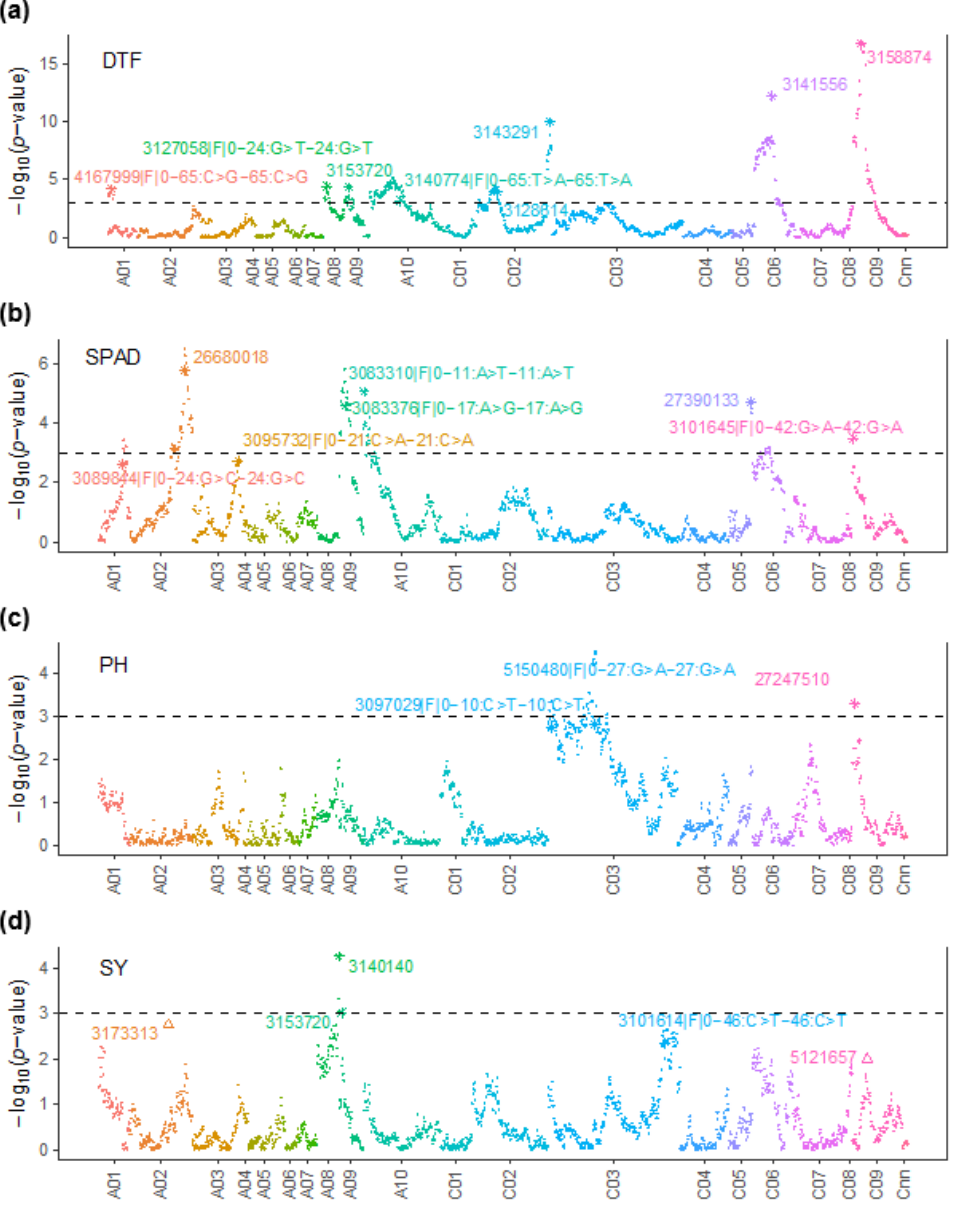
Figure 4. Manhattan plots showing genomic regions associated with ( a ) DTF: Days to flower; ( b ) SPAD: Chlorophyll content; ( c ) PH: Plant height; and ( d ) SY: Seed yield, in the DH population. The QTL for main effects are depicted by ‘*’, and the QTL by Environment interactions are depicted by ‘Δ’. The LOD (-log 10 p- value) scores presented in the Manhattan plot are from the genome scan for the QTL main effects where the LOD scores of the significant QTL are replaced with the values from the final model. The black dashed line indicates the threshold value for significant SNPs at LOD ≥ 3. The physical positions of DArTseq markers ( x -axis) are based on the map position on the Darmor- bzh genome assembly (for detail, see Supplementary Table S2).